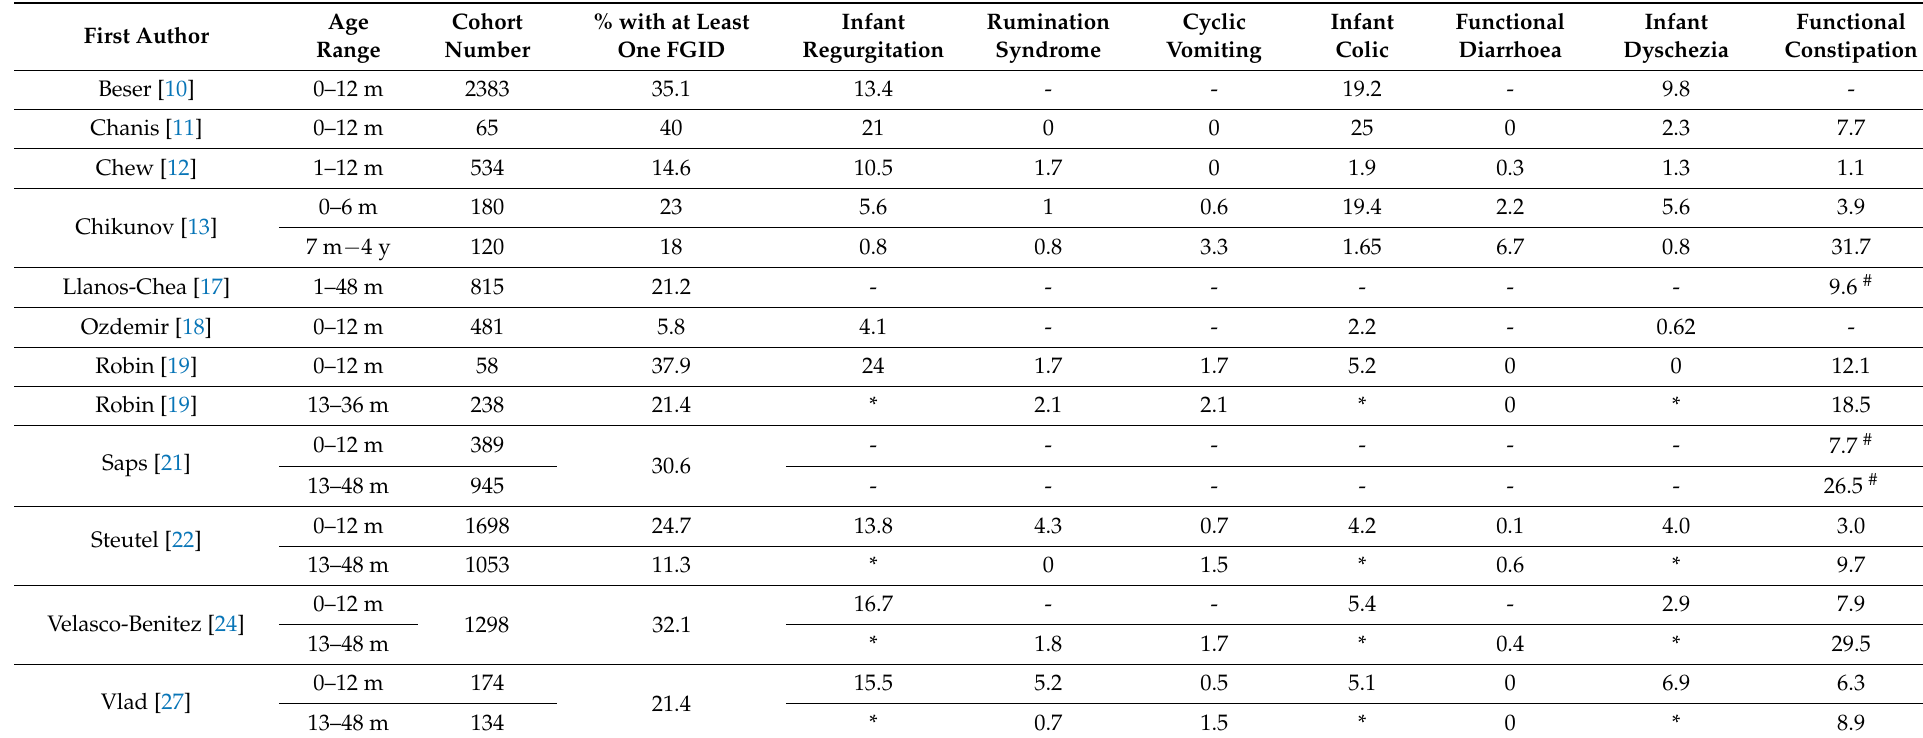
Table 2. Prevalence of overall and sub-category FGID among cohorts of children under the age of four